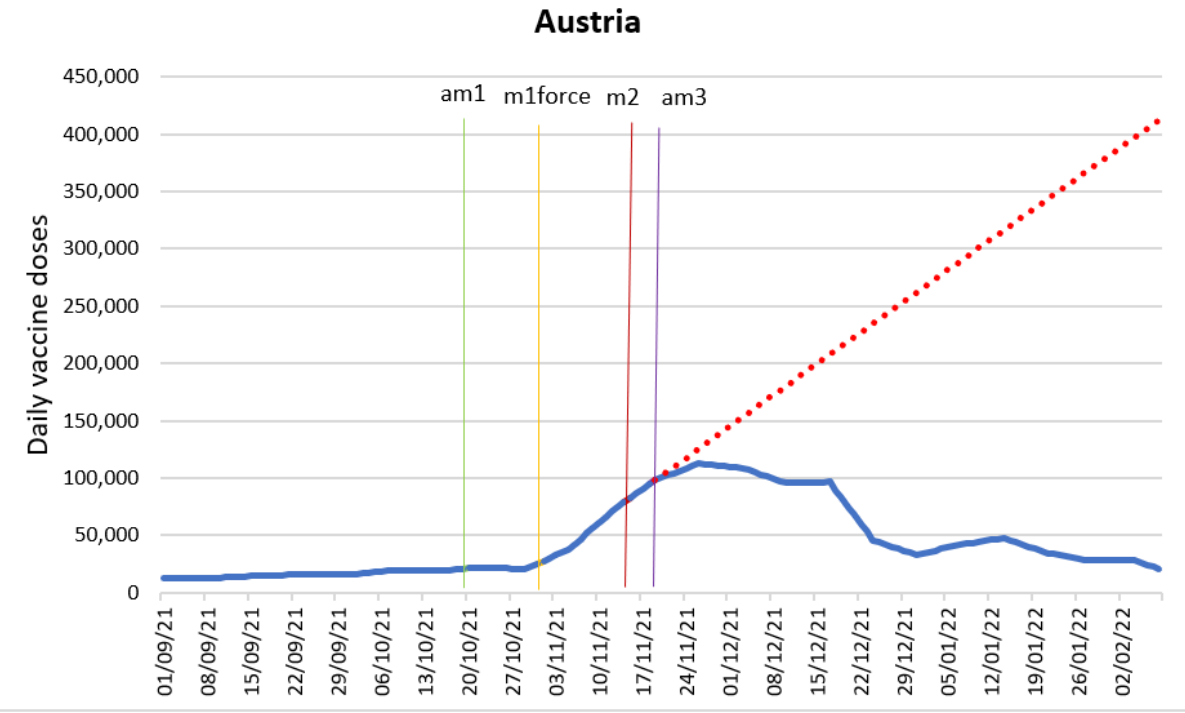
Figure 1. Daily new vaccinations in Austria before and after the policy changes and predicted values in absence of intervention based on ARIMA model.